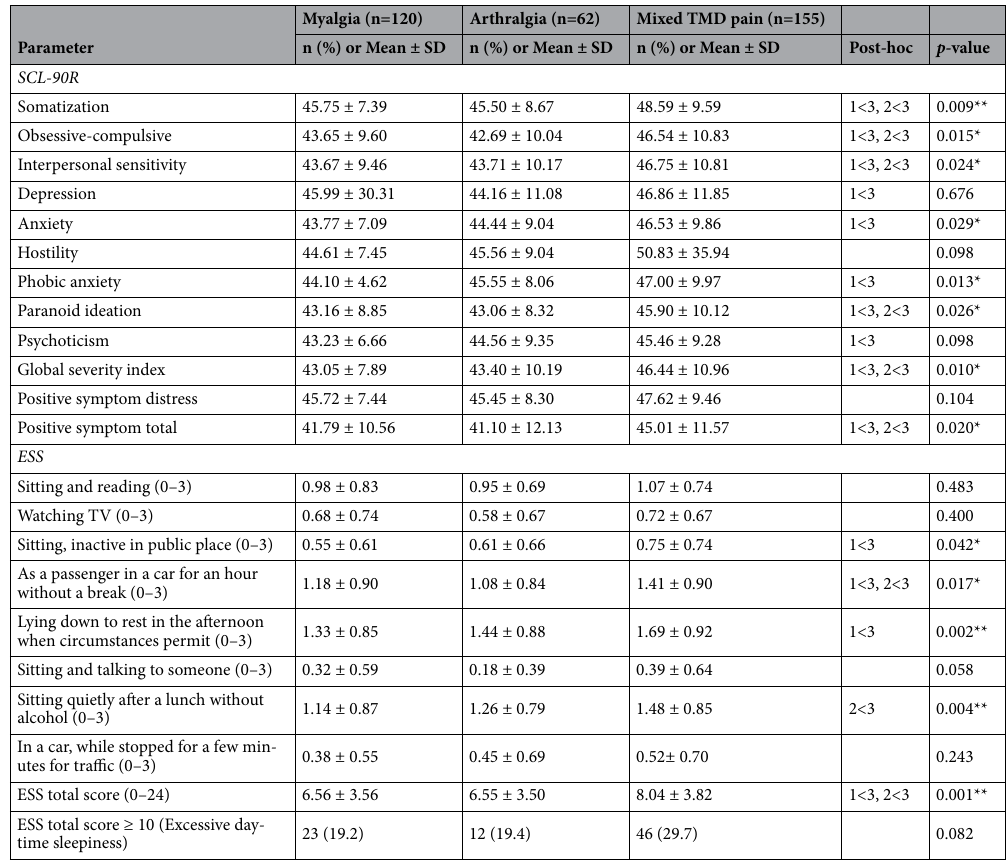
Table 3. Comparison of psychological profile with SCL-90R and excessive sleepiness scale between TMD groups. The results were obtained from χ 2 test with Bonferroni adjusted post hoc analysis and the mean difference between groups was obtained by ANOVA with Tukey’s post-hoc test. p -Value significance was set at <0.05. *: p -value <0.05, **: p -value <0.01. TMD: temporomandibular disorder, VAS: visual analogue scale, SD: standard deviation, ESS: Epworth sleepiness scale, 1 in Post-hoc test: the mean value of myalgia group, 2 in Post-hoc test: the mean value of arthralgia group, 3 in Post-hoc test: the mean value of mixed TMD pain